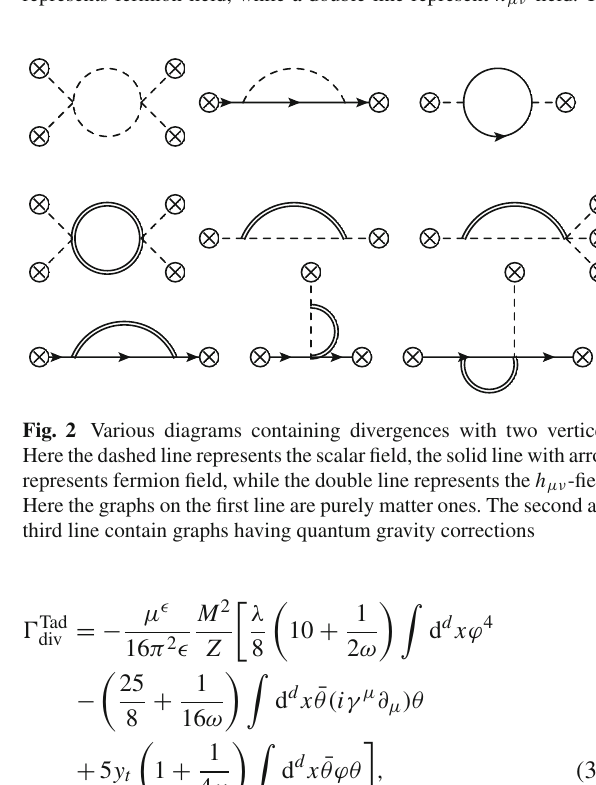
Fig. 1 Various diagrams containing divergences at the tadpole level. Here the dashed line represents the scalar field, solid line with arrow represents fermion field, while a double line represent h μν -field. The